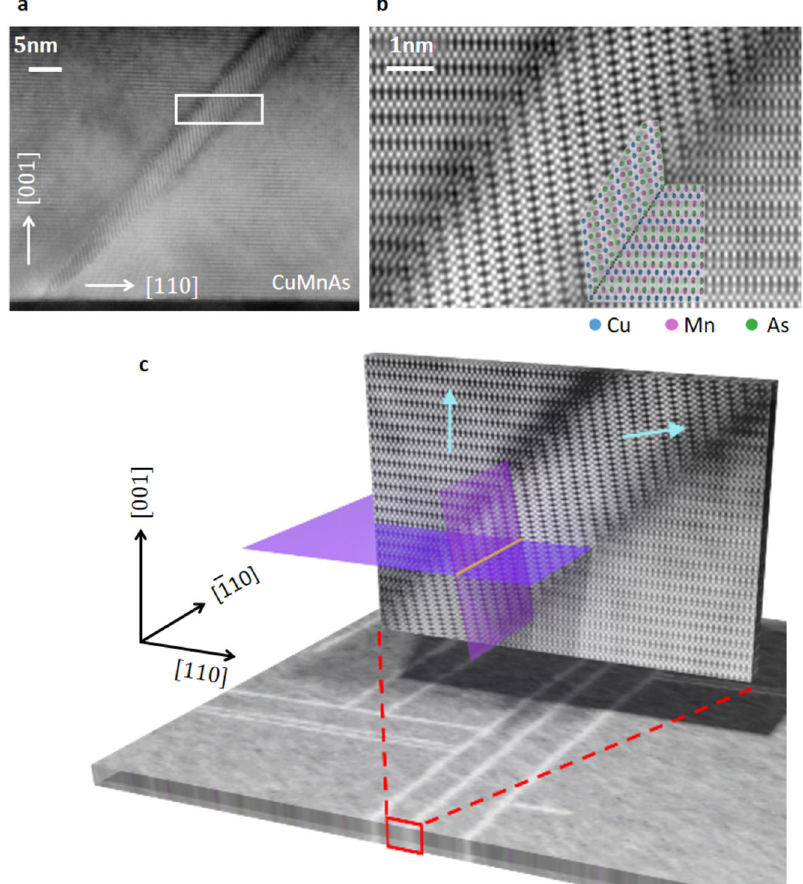
Fig. 3 Atomic structure of the microtwin defects. a HAADF-STEM image of a microtwin defect in a CuMnAs thin fi lm. b HAADF-STEM image from the area shown by the white rectangle in ( a ), with an atomic model overlay. The microtwin and surrounding bulk fi lm form a coherent boundary indicated by the gray line. c SXDM map of defect lines on the CuMnAs(001) surface (horizontal panel) and HAADF-STEM image (vertical plane) of a microtwin defect. Teal arrows give the local c -axis orientation. Purple sheets indicate the magnetic easy planes in the microtwin and the surrounding fi lm. The orange line shows the intersection of the magnetic easy planes which determines the local spin axis for the microtwin and surrounding